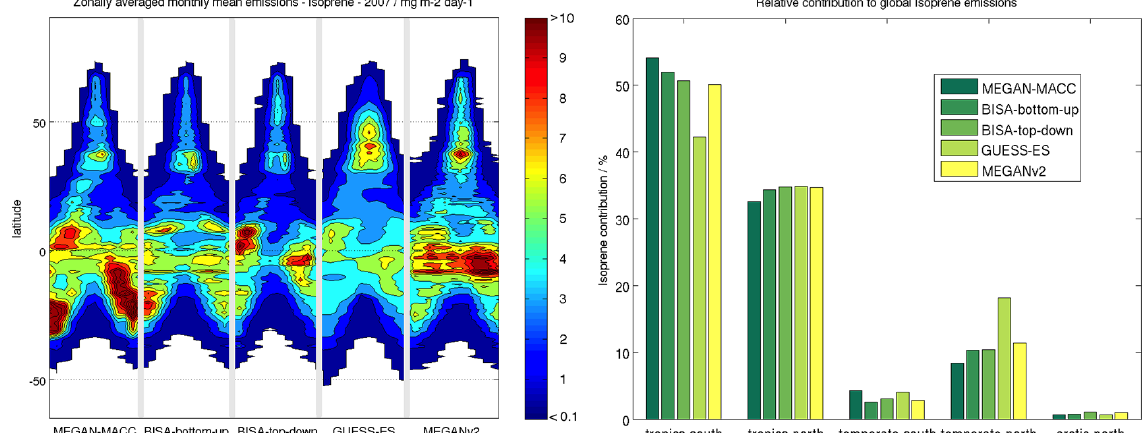
Figure 12. Comparison of zonal means of isoprene monthly emissions (mgm − 2 day − 1 ) (left) and relative contributions of zonal bands to isoprene annual global total for different emission data sets in the year 2007 (2003 for MEGANv2). Colours assigned to each data set are given in the enclosed legend. The extent of zonal bands is the same as in Fig. 5.